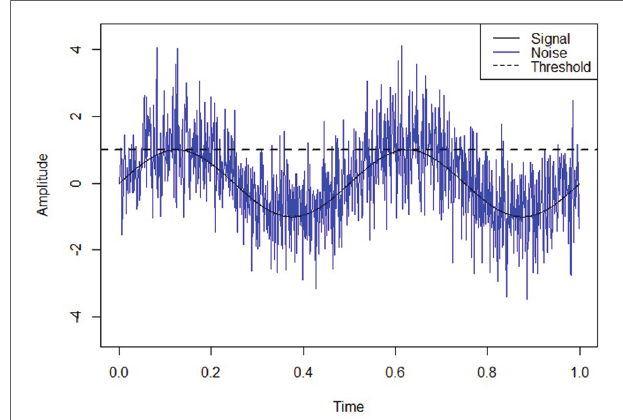
FIGURE 1 | The stochastic resonance concept. The addition of white noise has the effect of providing information about the underlying, sub-threshold signal. In this theoretical example, superimposed noise elevates the signal above threshold, revealing information about its inherent sinusoidal